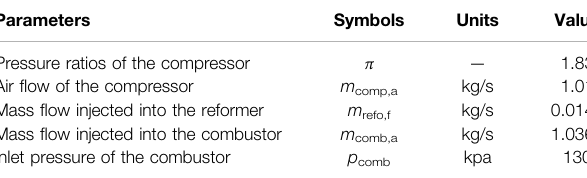
TABLE 2 | Input condition for validating the mass model (Freeh et al., 2005). Parameters